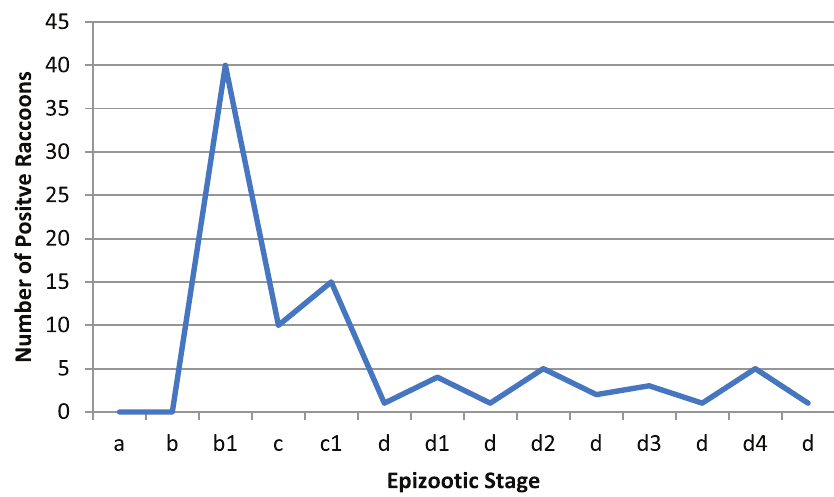
Figure 2. Schematic of the temporal stages of a typical county in New York during the raccoon rabies epizootic from 1992 to 2000. Stage a: Pre-raccoon variant – rare cases in raccoons; cases of raccoon rabies might spill over from other wildlife. b1: initial epizootic of raccoon variant rabies as it moves through the county. c1: sequential epizootic. d1: sequential inter-epizootics. (Adapted from Gordon et al. , 2004 13